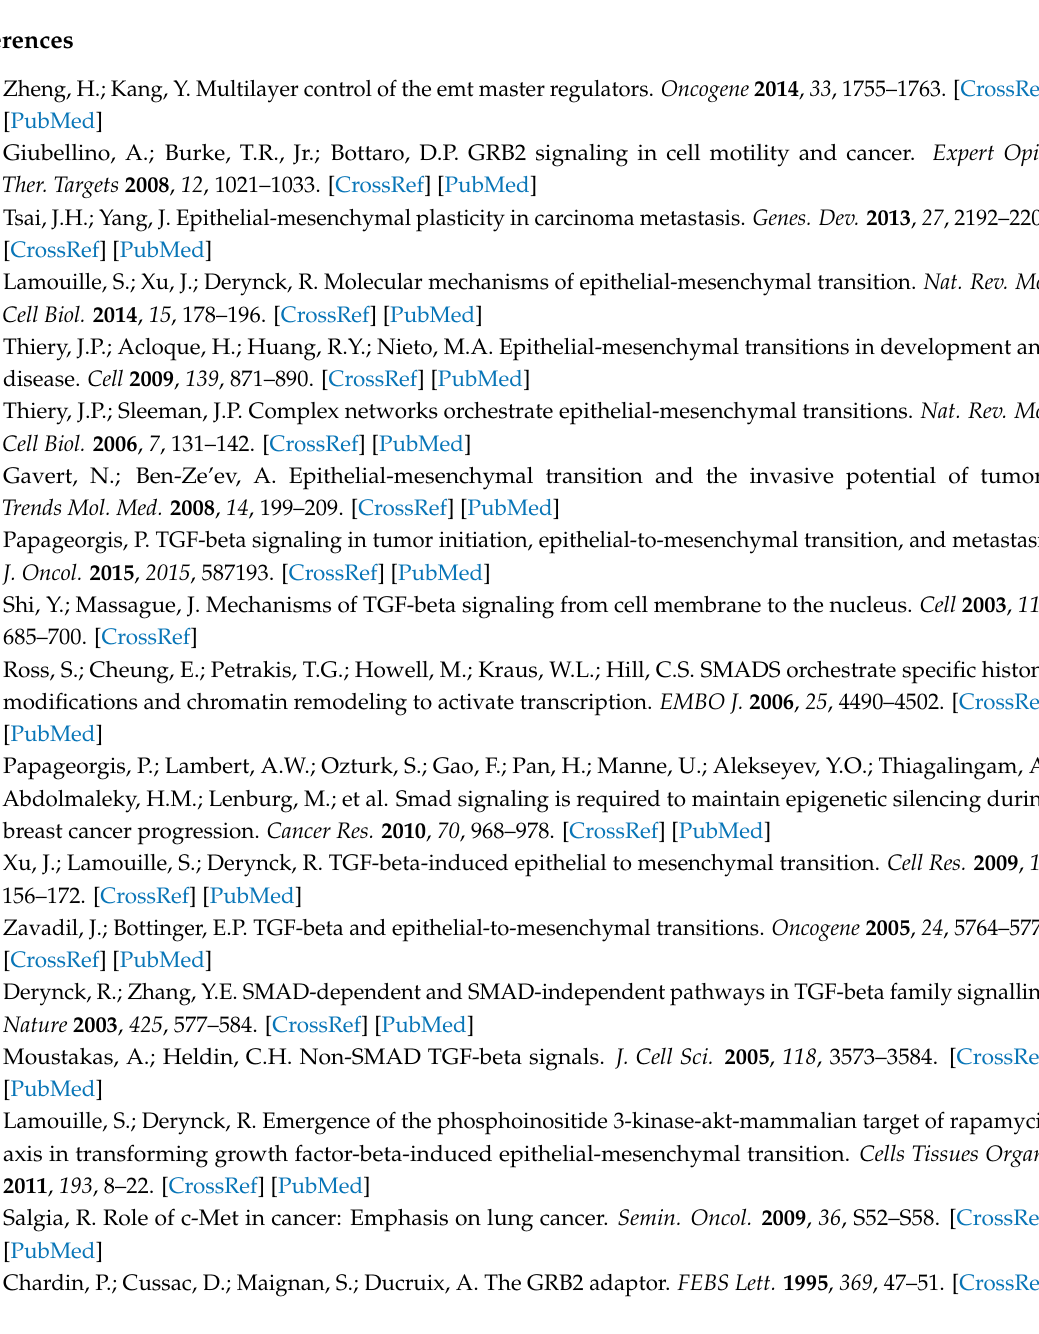
Figure S1: TGF- β 1 treatment did not enhance transcription of GRB2 mRNA. Figure S2: Knockdown of GRB2 did not cause any change to TGF- β 1 induced EMT in A549 cells. Figure S3: GRB2 overexpression causes activation of ERK, on TGF- β 1 stimulation, in A549